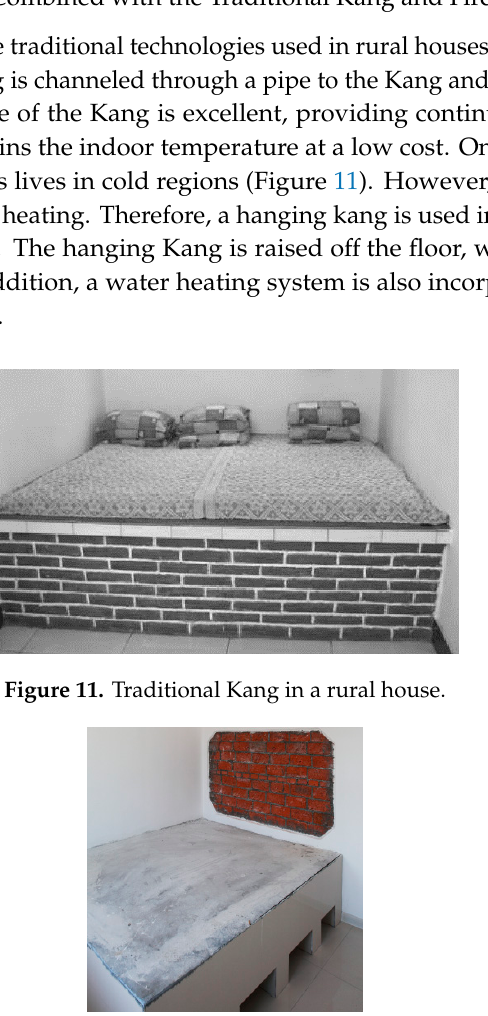
Figure 12. A hanging Kang in the demonstration building.